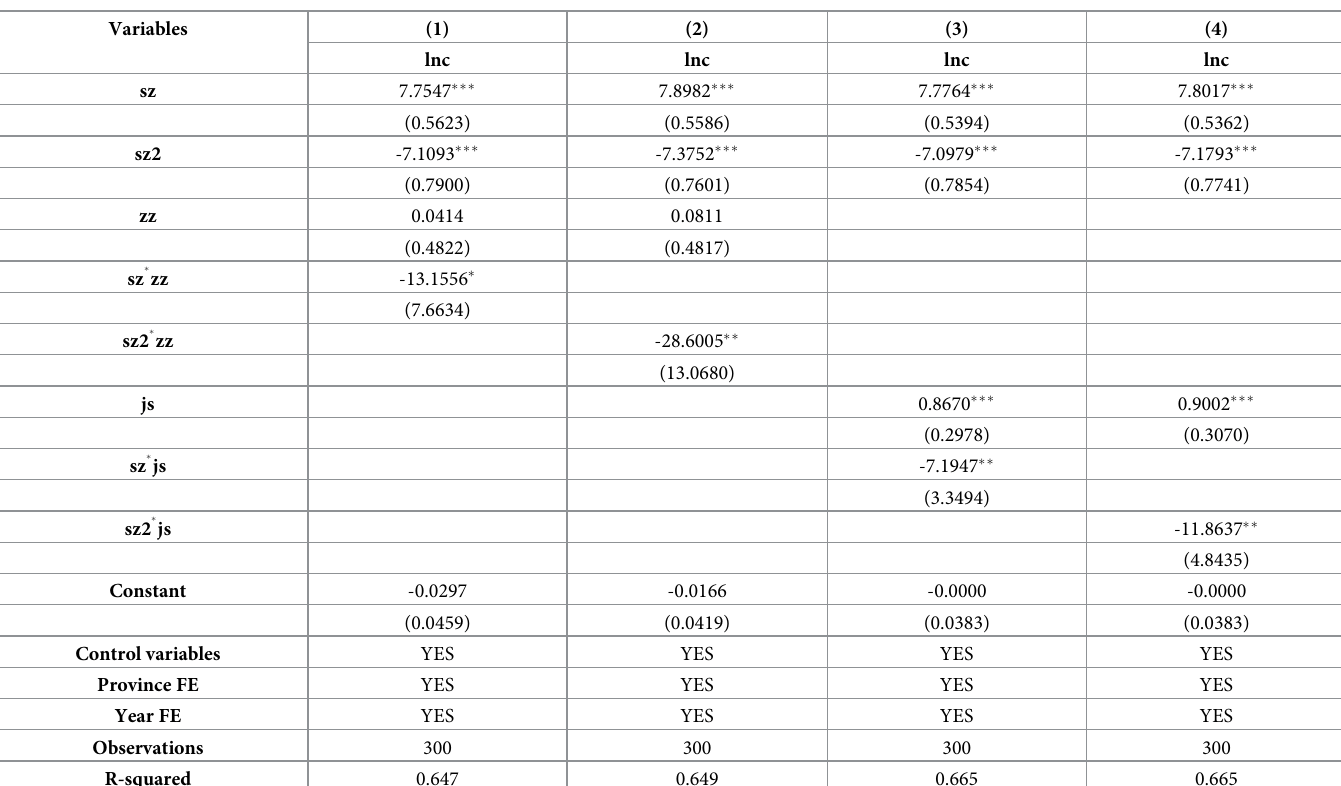
Table 6. Conduction mechanism